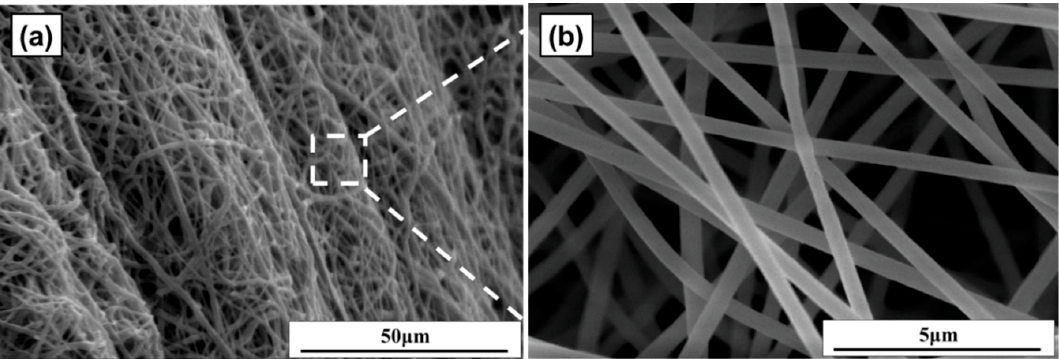
Figure 7. SEM images of the fiber membranes WPU/SA 30 blend view ( a ); the enlarged view of these fibers ( b ). The scales bars in ( a , b ) are 50 and 5 µ m, respectively.